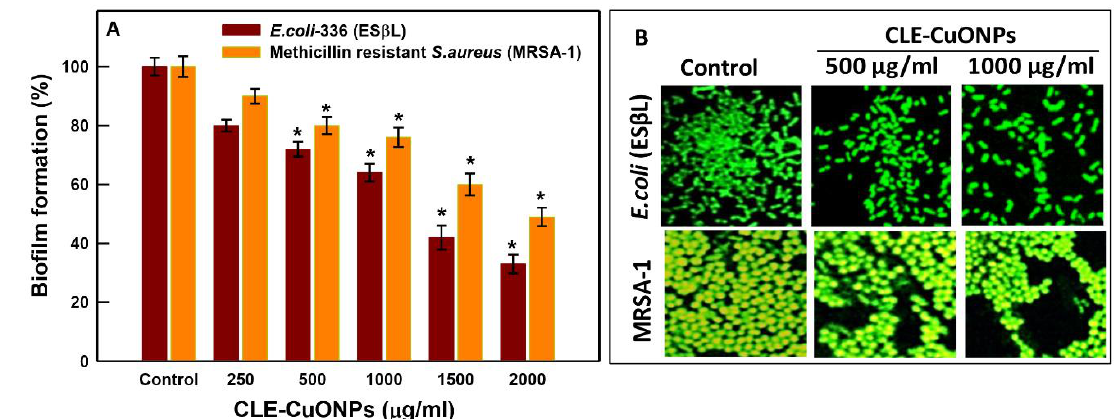
Figure 9. CLE-CuONPs induced antibiofilm activities in clinical isolates. ( A ) quantitative estimation of CLE-CuONPs showing inhibition of bacterial biofilm formation. The error bars represent mean ± SD of two independent experiments done in triplicates. * p < 0.05 vs. control; ( B ) qualitative analysis showing reduction in the biofilm formation by clinical isolates after CLE-CuONPs exposure analyzed by CLSM.